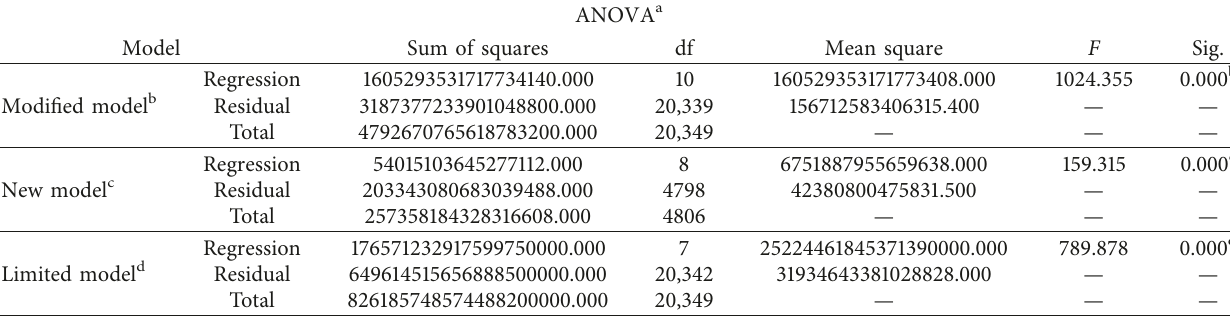
Table 23: ANOVA for a DOE large office building depending on different